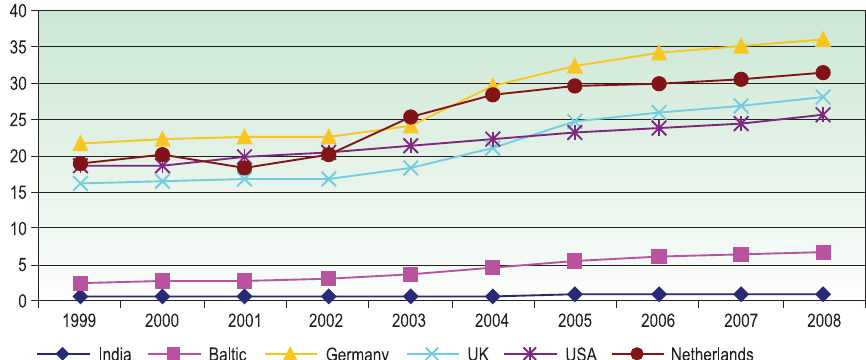
Fig. 5. Hourly compensation costs in manufacturing, US dollar/hour Source: Steelmaking economics. International labour cost comparisons: http://www.steelonthenet.com/labour_cost.html ; EUROSTAT